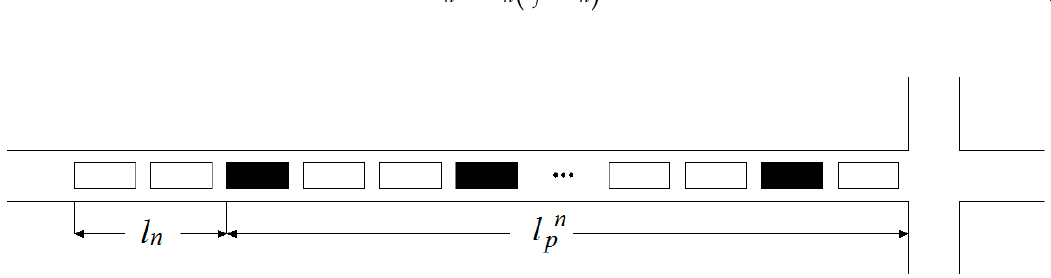
Figure 3. Schematic diagram of n connected vehicles.